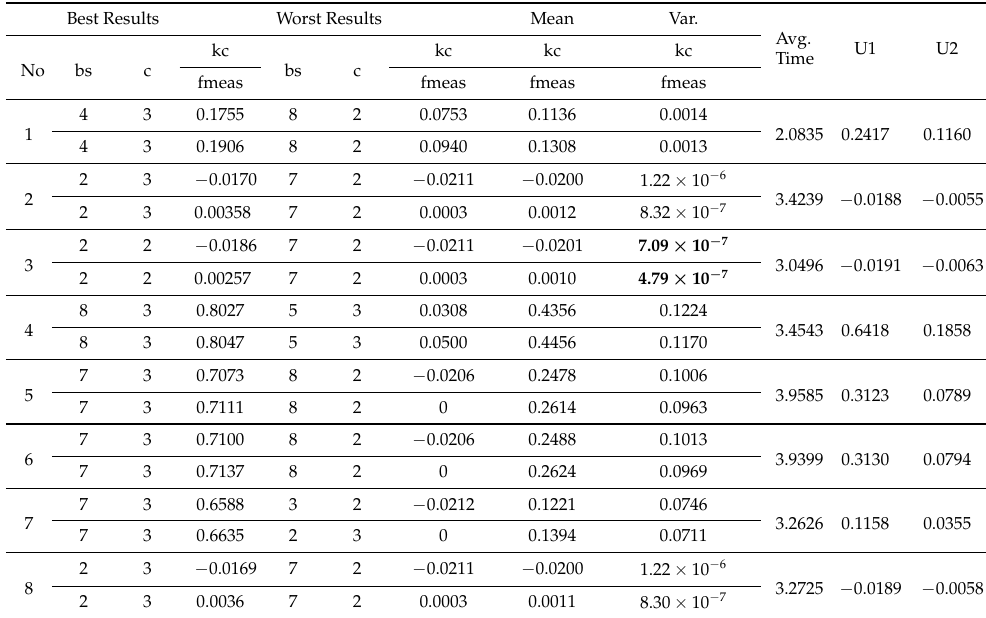
Table A3. Results of Yellow River Estuary